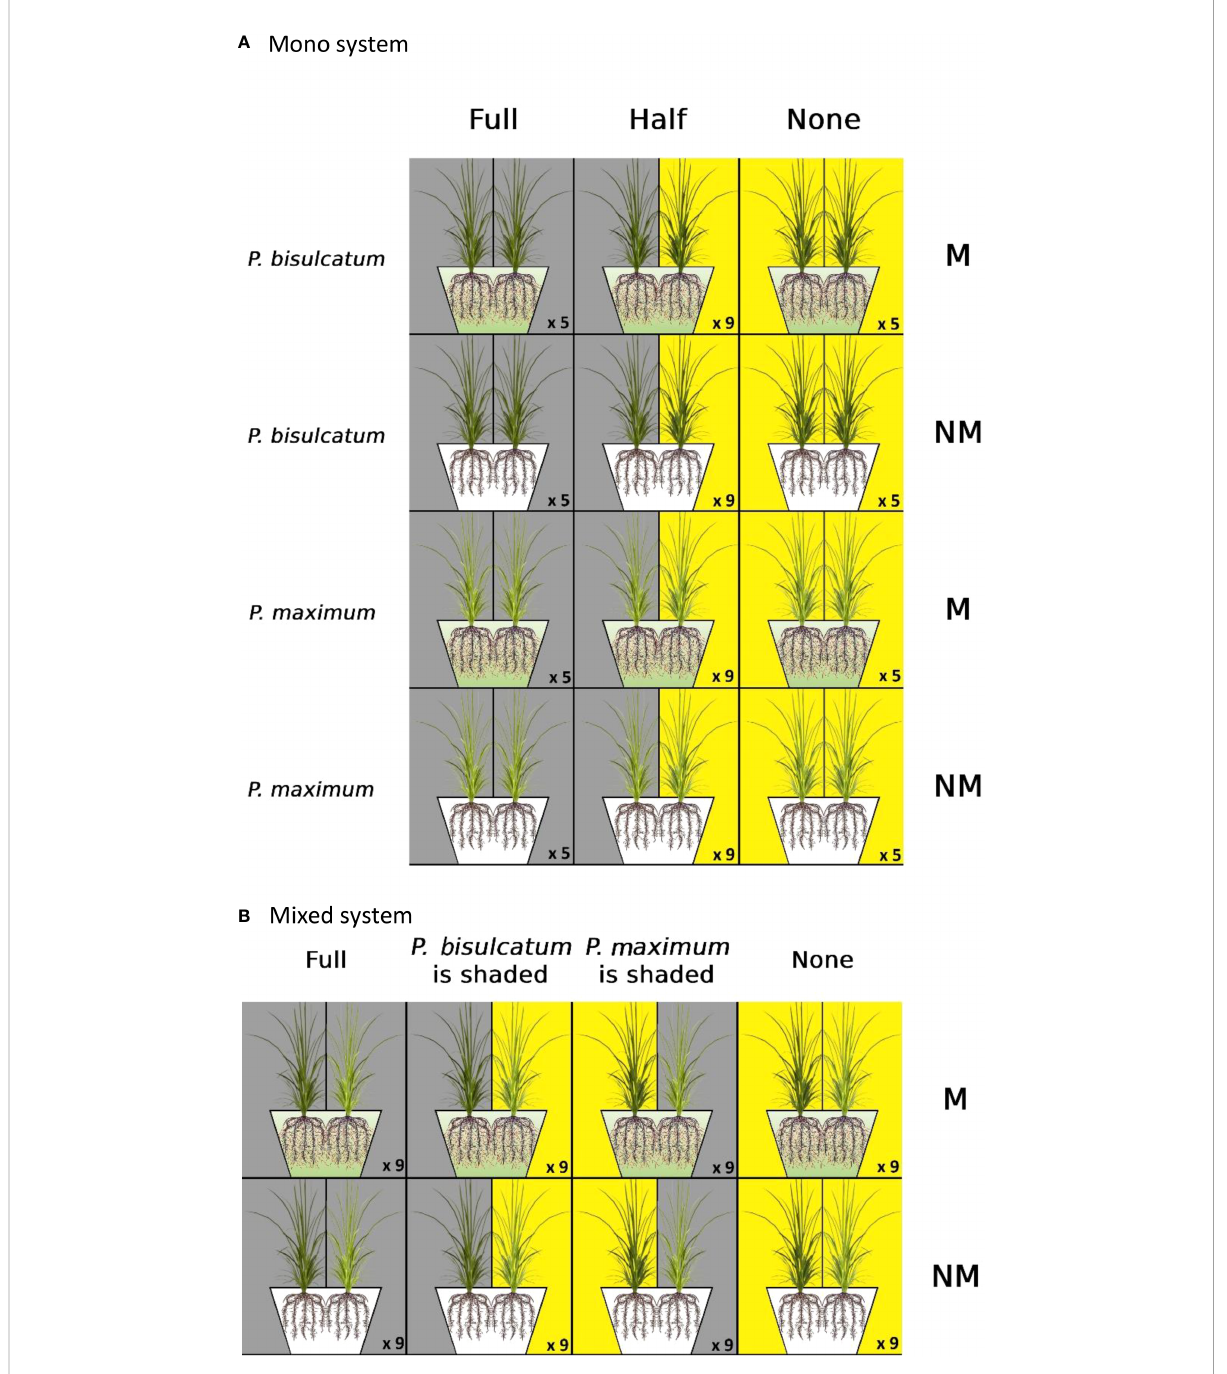
FIGURE 1 (A) Experimental setup in the mono system; two individuals of either plant species ( Panicum bisulcatum or P.maximum ) were grown in the same pot and exposed to three light regimes ( “ full, ” in which both plant individuals in each pot were shaded, “ half, ” in which only one of the plant individual was exposed to shade, and “ none, ” in which both plants were exposed to full light). Plant individuals in each pot were either inoculated with arbuscular mycorrhizal (AM) fungus – constituting the mycorrhizal (M) treatment, whereas the AM fungus was absent in the non-mycorrhizal (NM) treatment. (B) Experimental setup for the mixed system; plant species (one individual of P.bisulcatum and one of P.maximum ) with two mycorrhizal statuses (M/NM) were grown side by side as pairs of different plant species in the same pot, and exposed to four light regimes ( “ full ” , in which both plant individuals in each pot were shaded, “ P.bisulcatum is shaded ” , in which only P.bisulcatum was exposed to shade, “ P.maximum is shaded ” , in which only P.maximum was shaded, and “ none ” , in which no plant was shaded). The number of replicates is indicated for each treatment